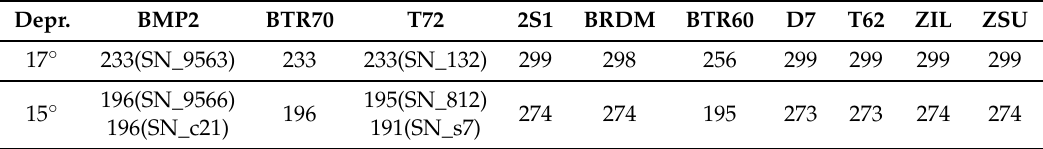
Table 3. The number of images for ten class targets.